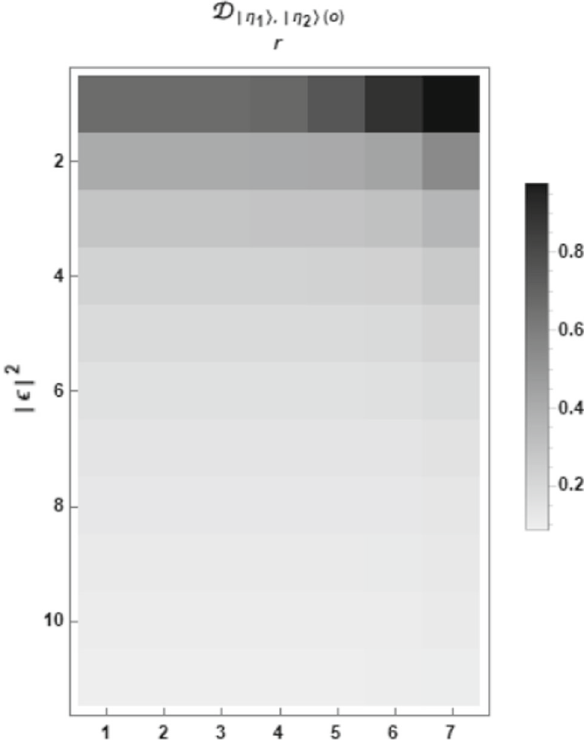
Fig. 14 Array plot for the Table 9 showing numerical values of D T | η 1 (cid:3) 12 ; | η 2 (cid:3) 12 ( o ) tabulated in the form of a matrix for some range of coherent and squeezing parameters